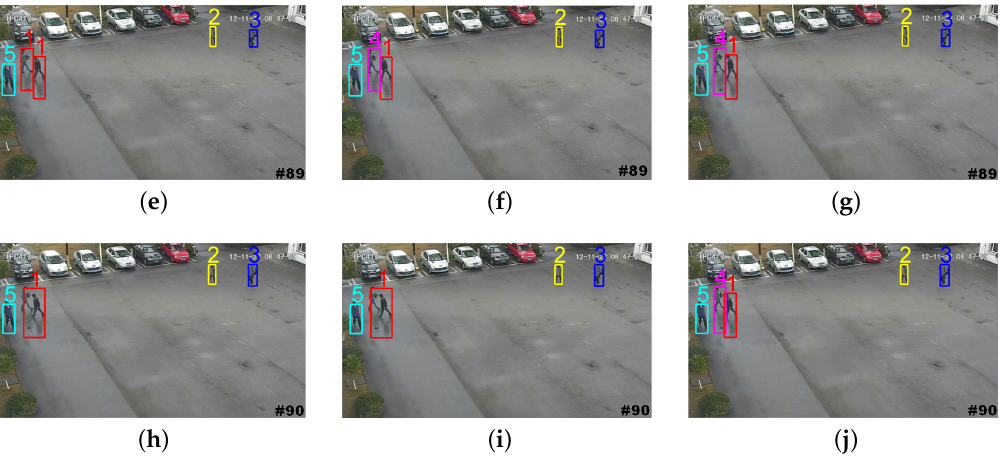
Figure 9. Tracking results on an outdoor human surveillance scenario. ( a , d ) Tracked targets by the GM-PHD tracker; ( b , e ) tracked targets by the CPGM-PHD tracker; ( c , f ) tracked targets by our tracker.